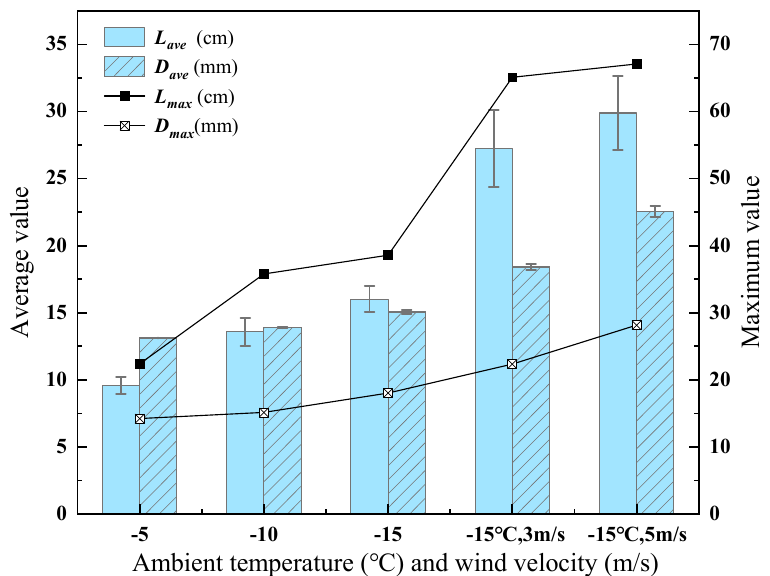
Figure 10. The icicle histograms: ( a ) − 5 °C, ( b ) − 10 °C, ( c ) − 15 °C, ( d ) − 15 °C and 3 m/s, ( e ) − 15 °C and 5 m/s.